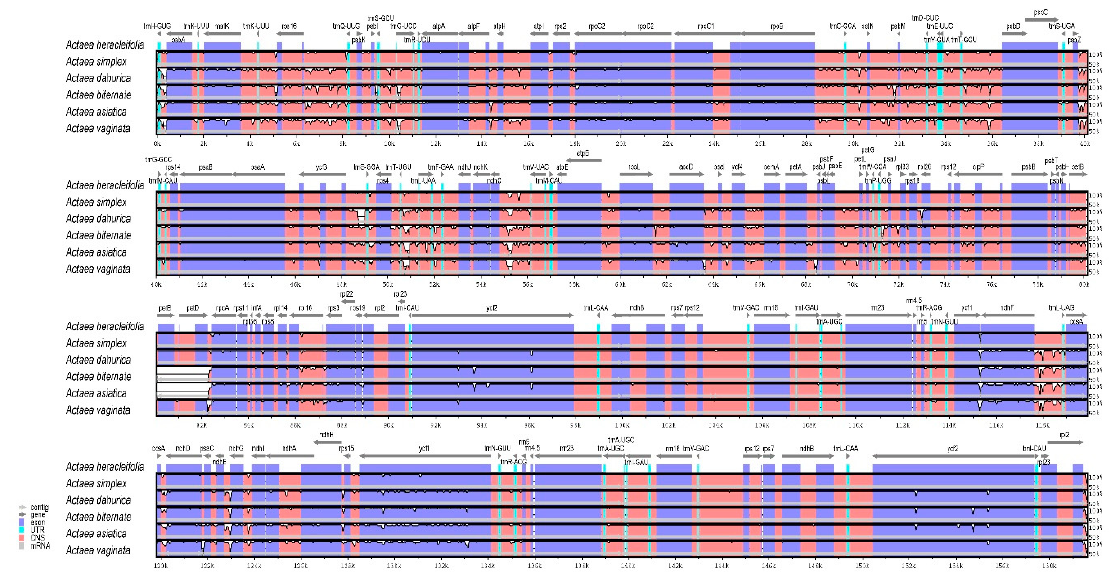
Figure 2. Comparative analysis of the cp genomes of six Actaea species, including A. simplex , A. dahurica , A. biternata , A. heracleifolia , A. asiatica , and A. vaginata , using mVISTA. The cp genome of A. heracleifolia used as a reference. Blue blocks, conserved genes; sky-blue blocks, tRNA and rRNA genes; red blocks, conserved non-coding sequences (CNSs); white blocks, regions polymorphic among the six Actaea species. A cut-off of 50% identity was used for the plots. The Y-axis represents a 50%–100% identity.